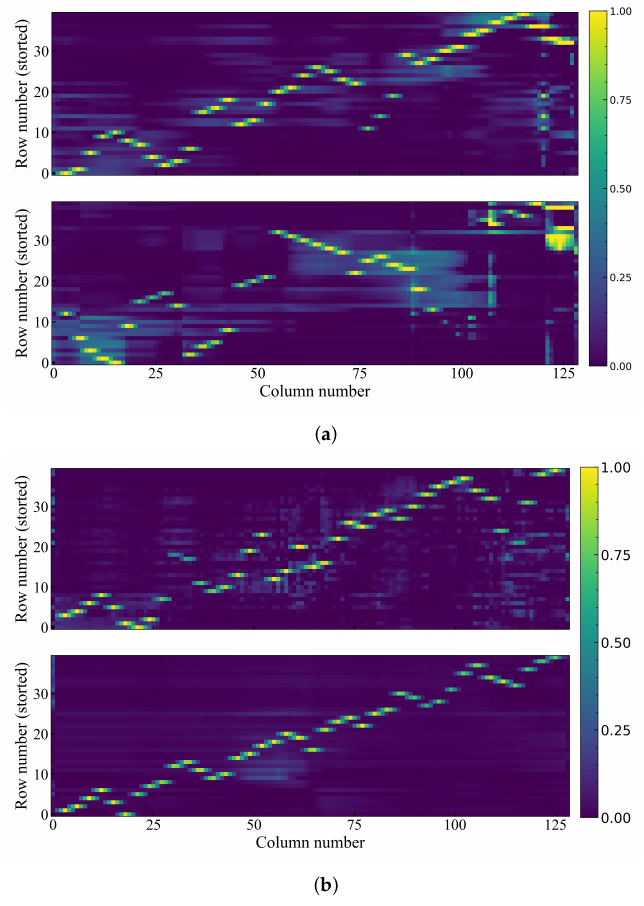
Figure 14. Learned weight matrix. ( a ) Amplitude feature extraction: log activation ( up ) and power activation ( down ); ( b ) phase feature extraction: Log activation ( up ), power activation ( down